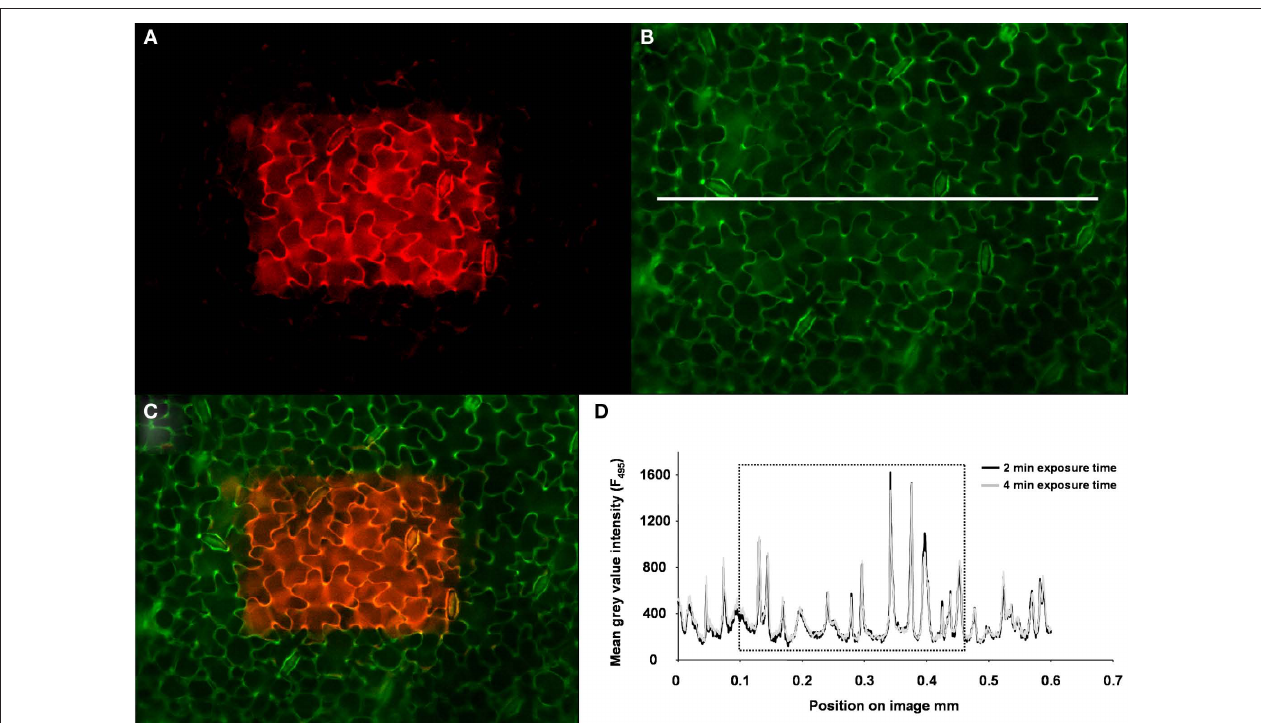
pseudo-green yields orange) represents the part of the leaf with the possibly bleached dye, whereas the pseudo-green area represents the control part of the leaf. Image (B) was used to create a profile of the gray-value intensity from the area tagged by the white line as a measure for the dye signal intensity after 2 min of continuous excitation at 495 nm (dark-gray profile) and after 4 min of continuous excitation (light-gray profile). The gray-value intensity profiles